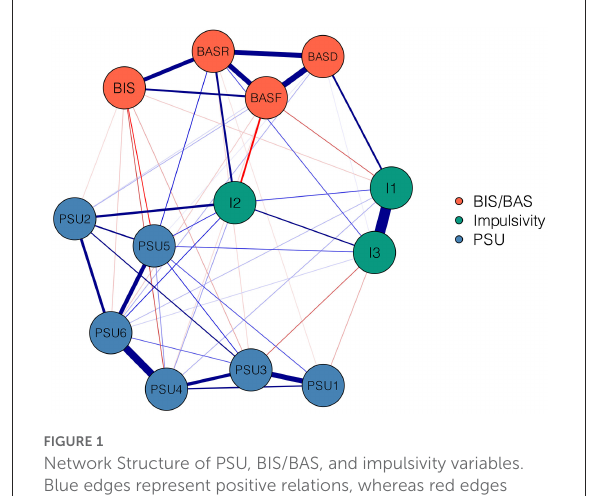
FIGURE1 Network Structure of PSU, BIS/BAS, and impulsivity variables. Blue edges represent positive relations, whereas red edges represent negative relations. Thickness of edge indicates strength of relationship. The weights of edges are in Supplementary Table 1. PSU1, salience; PSU2, conflict; PSU3, mood modification; PSU4, tolerance; PSU5, withdrawal; PSU6, relapse; BIS, Behavioral Inhibition System; BASR, Behavioral Activation System-reward responsiveness; BASD, Behavioral Activation System-drive; BASF, Behavioral Activation System-fun seeking; I1, non-planning impulsivity; I2, motor impulsivity;